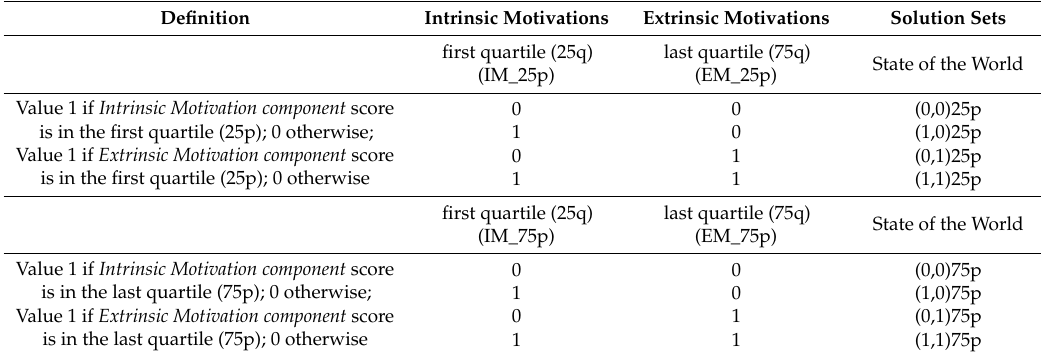
Table 7. States of the world for the two ‘extremes’ of the distribution of Intrinsic Motivations and Extrinsic Motivations indexes. Definition Intrinsic Motivations Extrinsic Motivations Solution